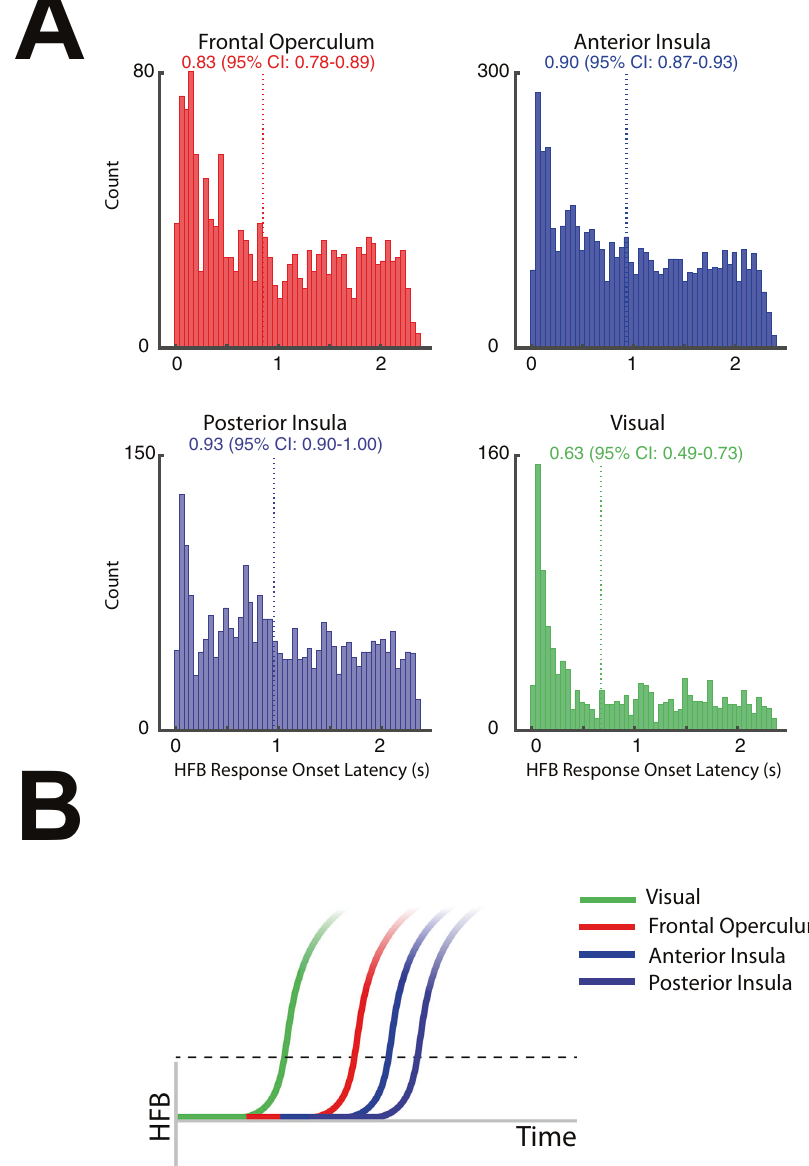
Fig. 4 Comparison of HFB response onset by anatomical location during task anticipation. A Histogram showing the distribution of response onset latency (ROL) of HFB at the frontal operculum, the anterior insula, the posterior insula, and visual regions. Each observation represents the ROL of HFB at the single-trial level calculated for all trials across all subjects (palatable and taste-neutral conditions). The vertical line denotes the median ROL time. B Schematic representing the sequence of HFB activity onset: early visual response to cue with the subsequent delay in activation of the frontal operculum, followed by involvement of anterior insula and subsequently posterior